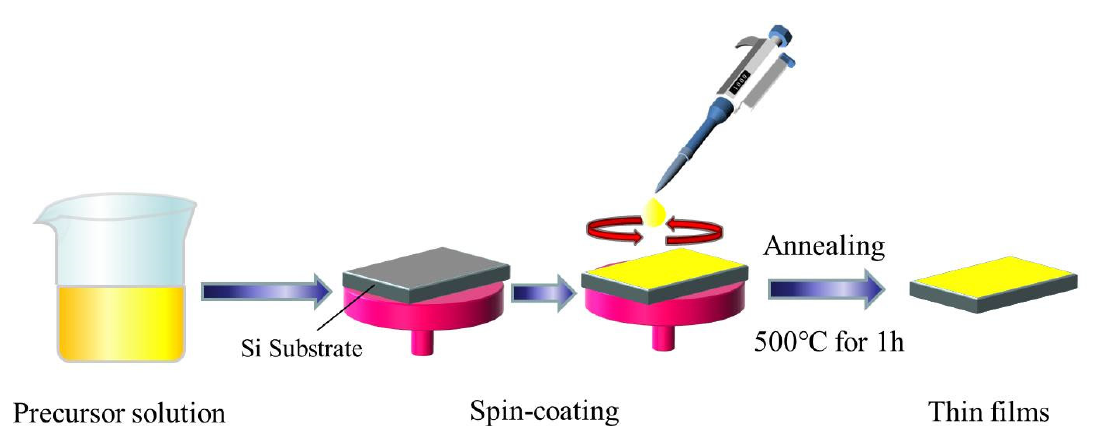
Figure 2. Diagram of the preparation process for pure BiFeO 3 (BFO) and BiFe 1-x Co x O 3 (BFC x O, x = 0.01, 0.03, 0.05, 0.07 and 0.10) composite thin films.